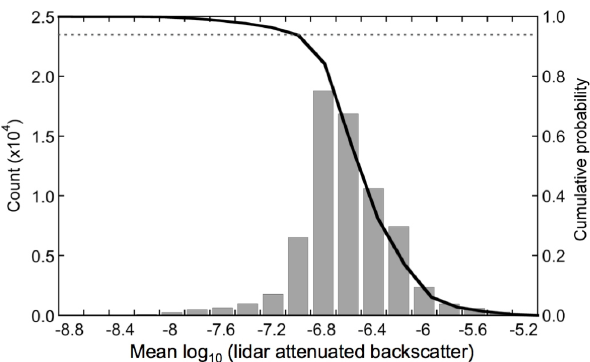
Figure 2. Histogram of β ct , 1km (the mean logarithm – with base 10 – lidar backscatter from the cloud top to 1km above) and the corresponding cumulative probability (solid line) accounted from the larger end of β ct , 1km for clear sky at the ARM Oklahoma site in 2005. The dashed line represents the 94% cumulative